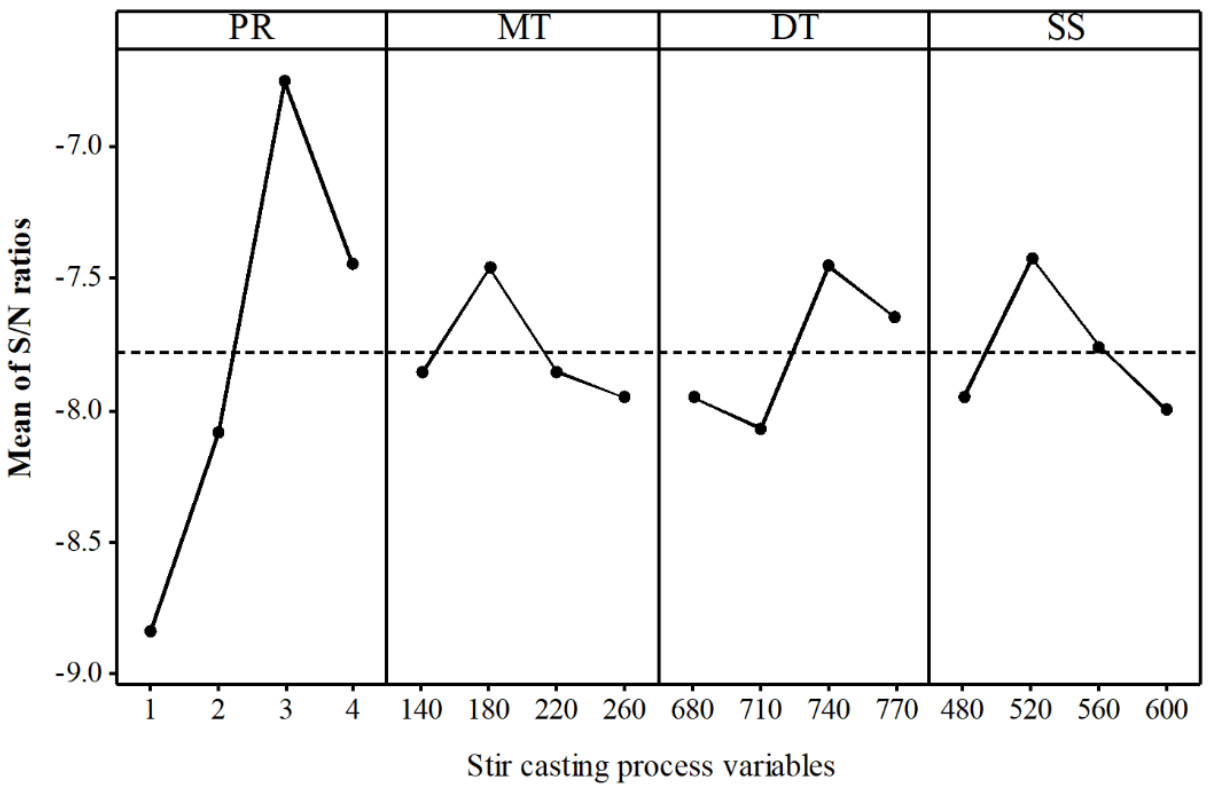
Figure 7. Main effect plots of wear rate of stir casting composites.